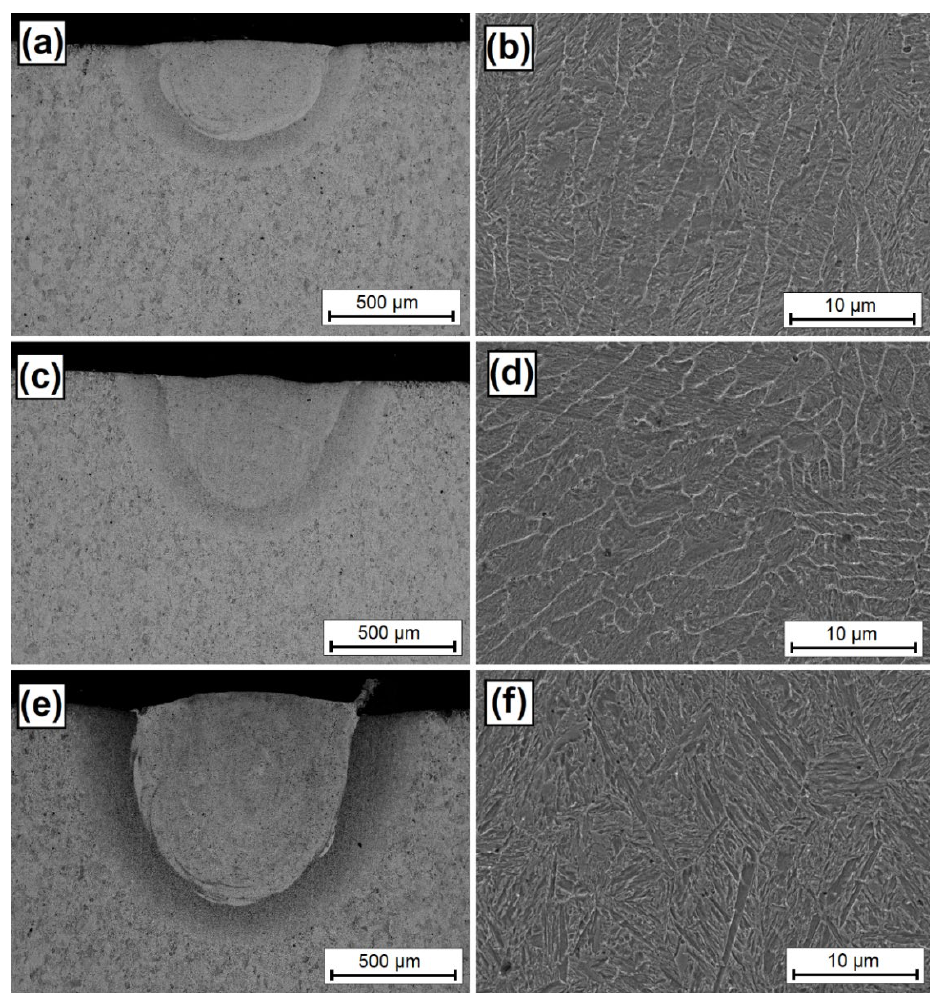
Figure 3. Microstructure of single laser tracks for various laser beam powers: ( a ) BSE image of coatings produced using 500 W, ( b ) SE image of the magnification of the middle area of the specimen produced using 500 W, ( c ) BSE image of coatings produced using 900 W, ( d ) SE image of the magnification of the middle area of the specimen produced using 900 W, ( e ) BSE image of coatings produced using 1100 W, ( f ) SE image of the magnification of the middle area of the specimen produced using 1100 W. All photos were taken in high vacuum at a voltage of 10